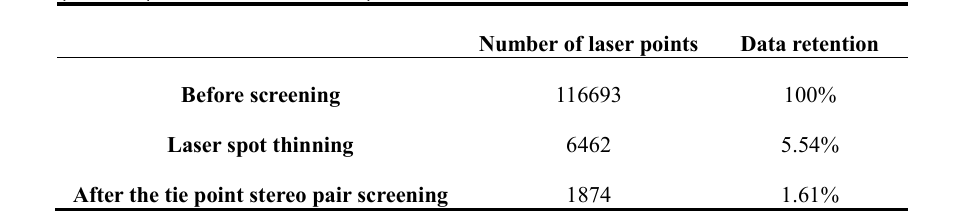
Table 2. Screening results based on tie points of stereo image